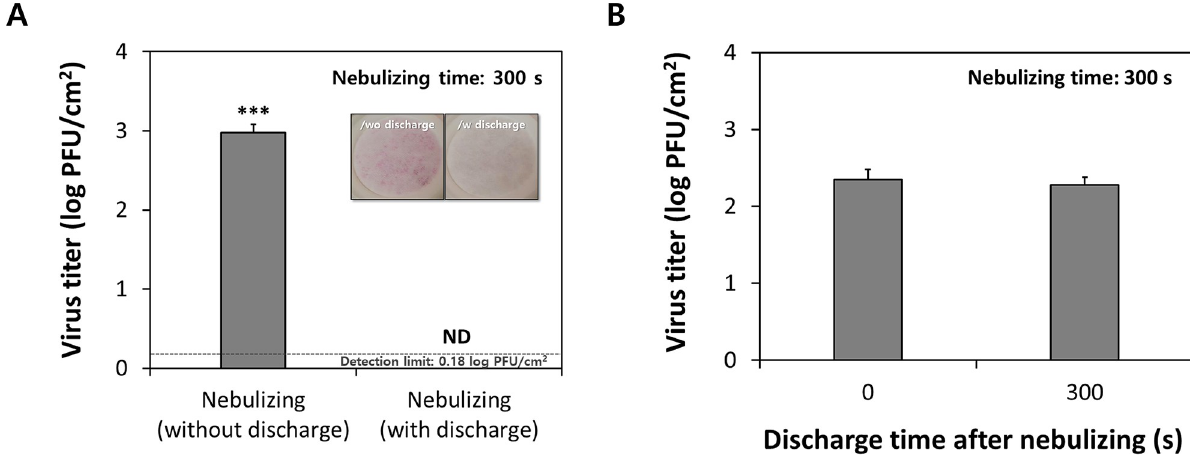
Fig 3. Inactivation of SARS-CoV-2 by DFD plasma. Infection of untreated and plasma-treated SARS-CoV-2 on Vero 76 cells. (A) SARS-CoV-2 aerosols were passed through the plasma generation area and were sprayed on the entire surface of the filter sample for 300 s. Inset: Visual aspects of filter samples according to plasma discharge during SARS-CoV-2 aerosol injection. (B) Plasma was applied to the filter-attached SARS-CoV-2 for 300 s after the virus solution was completely sprayed. Error bars indicate standard deviation ( n = 3). ND: not detected (detection limit: 0.18 log PFU/cm 2 filter). ��� p < 0.001 by Student’s t